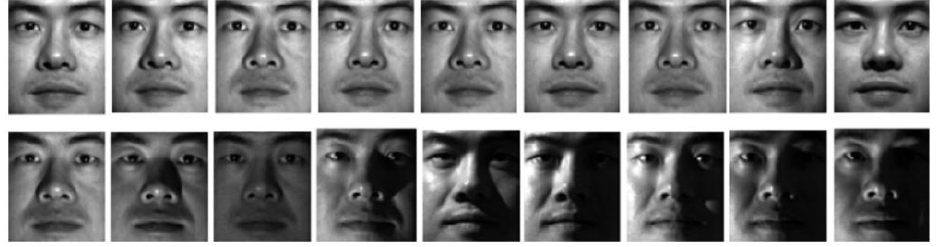
Figure 4. Typical sample images of Extended Yale B dataset.